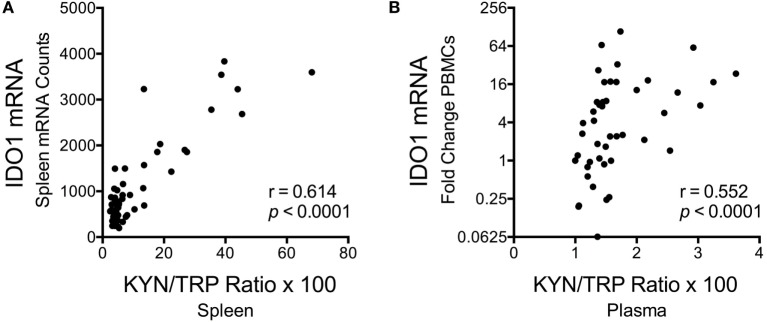
Correlations between longitudinal kynurenine (KYN)/tryptophan (TRP) ratios and IDO1 mRNA expression in spleen and blood of SIV-infected pigtailed macaques. (A) Spearman’s rank correlation of splenic IDO1 mRNA expression and splenic KYN/TRP ratios harvested from animals euthanized at various points postinfection (n ≥ 5 animals per timepoint). (B) Spearman’s rank correlation of peripheral blood mononuclear cell IDO1 mRNA expression and plasma KYN/TRP ratios from five animals followed longitudinally (3 preinfection blood draws averaged together, as well as 7 postinfection blood draws at days 7, 10, 14, 21, 28, 42, and approximately 84 dpi, are depicted).